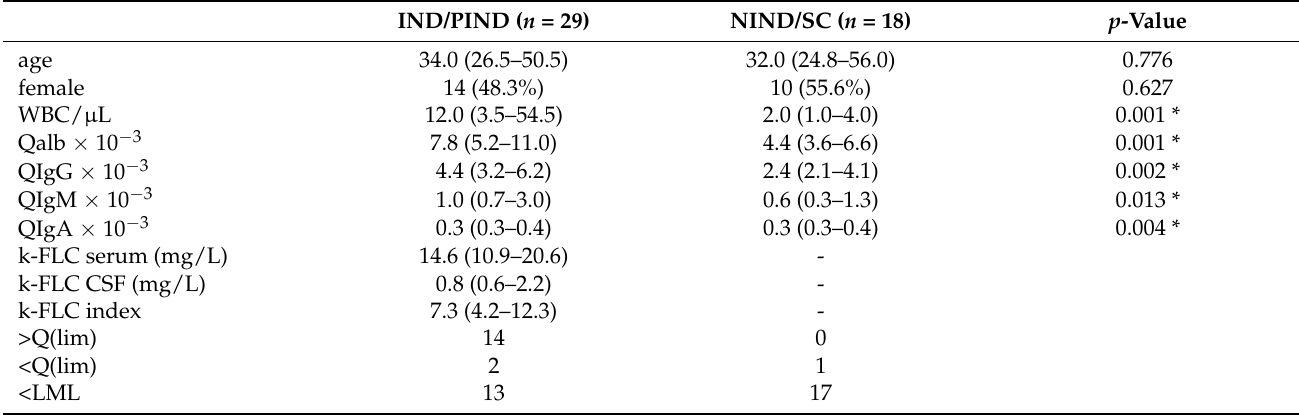
Table 1. Baseline characteristics and measurement results of the k-FLC according to the medical diagnosis of the patients with one isolated band in IEF.